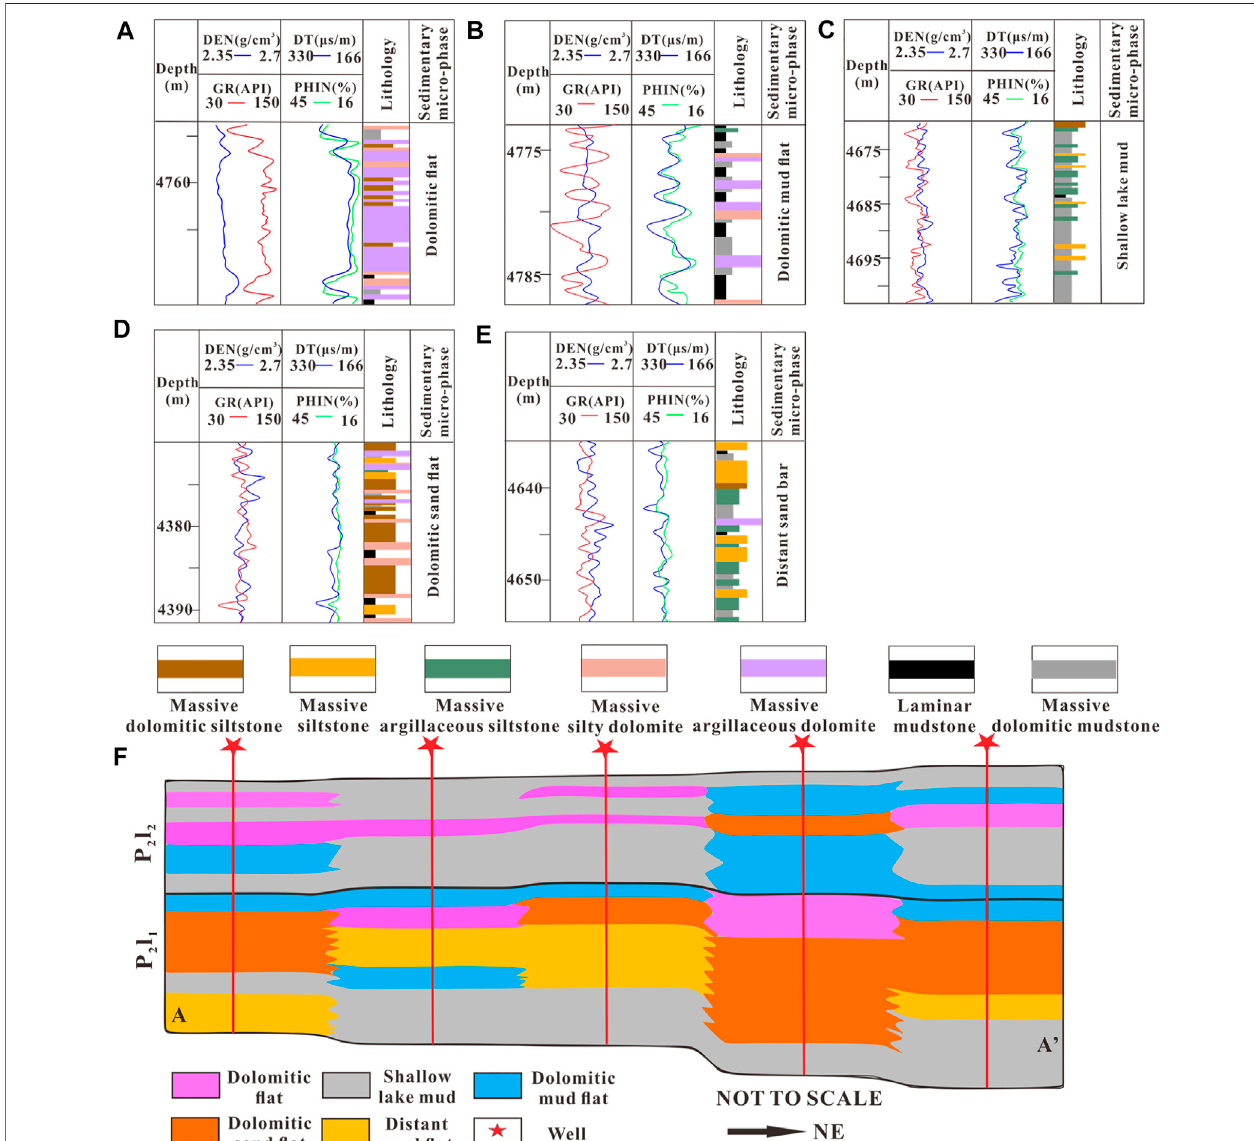
FIGURE 6 | Lithofacies assemblage type of the Lucaogou Formation. (A) Single dolomite lithofacies; (B) Interlayered dolomitic mudstone and dolomite lithofacies; (C) Inter-layered argillaceous siltstone and dolomitic mudstone lithofacies; (D) Dolomitic siltstone and argillaceous sandstone facies; (E) Argillaceous siltstone and siltstone lithofacies; and (F) Northeast-Southwest cross section of the Lucaogou Formation in the Jimusar Sag, Junggar Basin, showing the correlation between the different lithofacies and sedimentary environment.